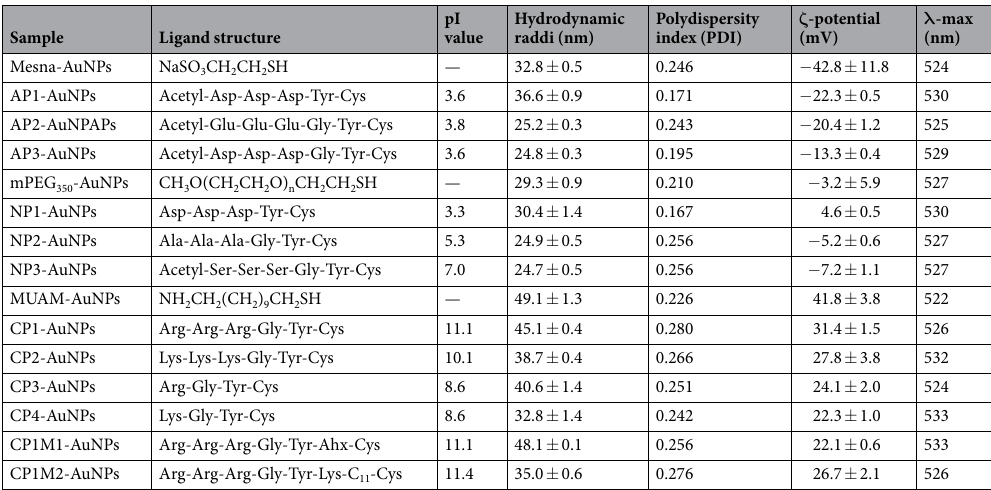
Table 1. Size, zeta( ζ )-potential, and UV-Vis spectra of modified gold nanoparticles (AuNPs) in deionized (DI) water. Hydrodynamic radii, ζ -potential values are represented as means ± standard deviation (n = 3) for all